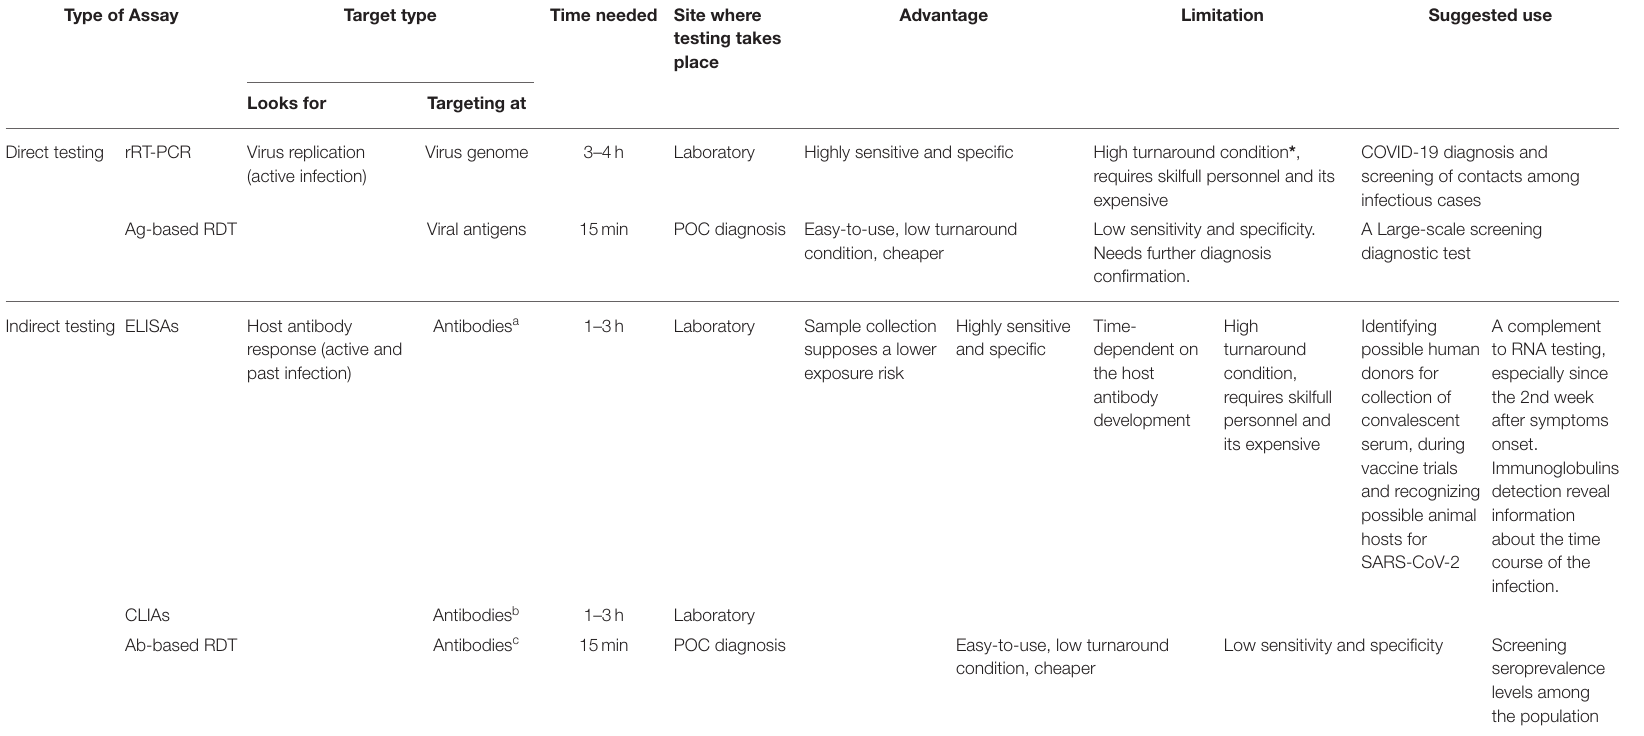
TABLE 4 | Comparison of current SARS-CoV-2 current diagnosis approaches